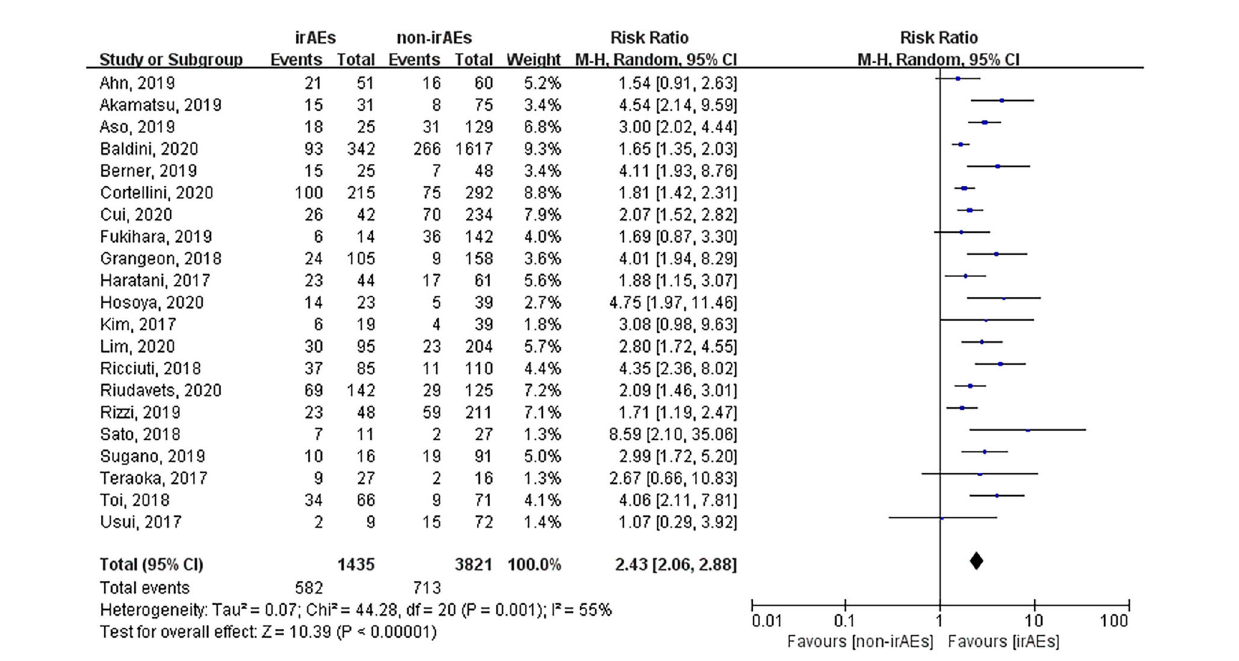
FIGURE 2 | Forest plot of the association between the occurrence of irAEs and ORR. ORR, objective response rate; irAEs, immune-related adverse events; non- irAEs, non-immune-related adverse events.